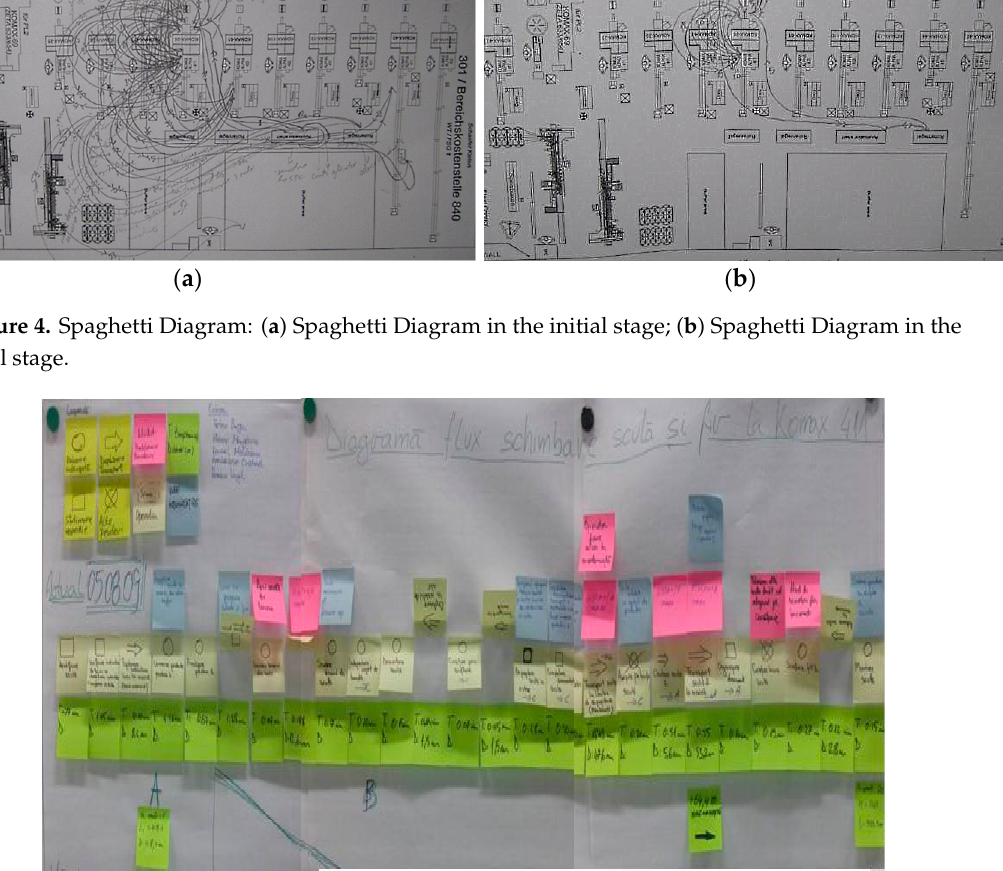
Figure 5. Value Stream Mapping (VSM).